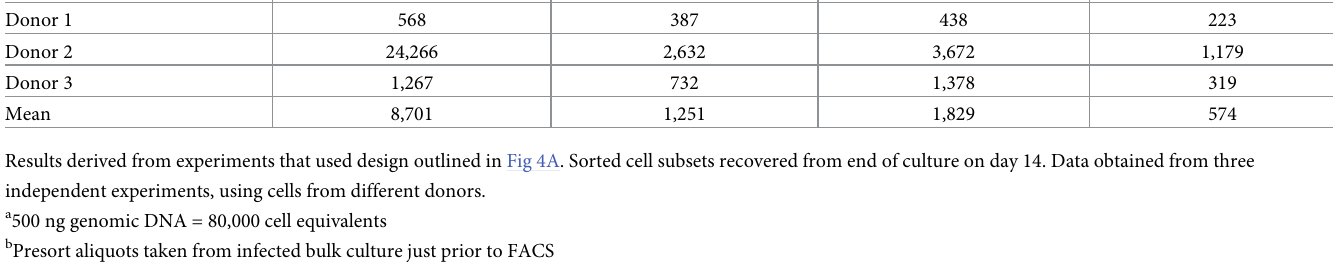
Table 2. Integrated HIV in sorted CFSE-stained cell subsets.